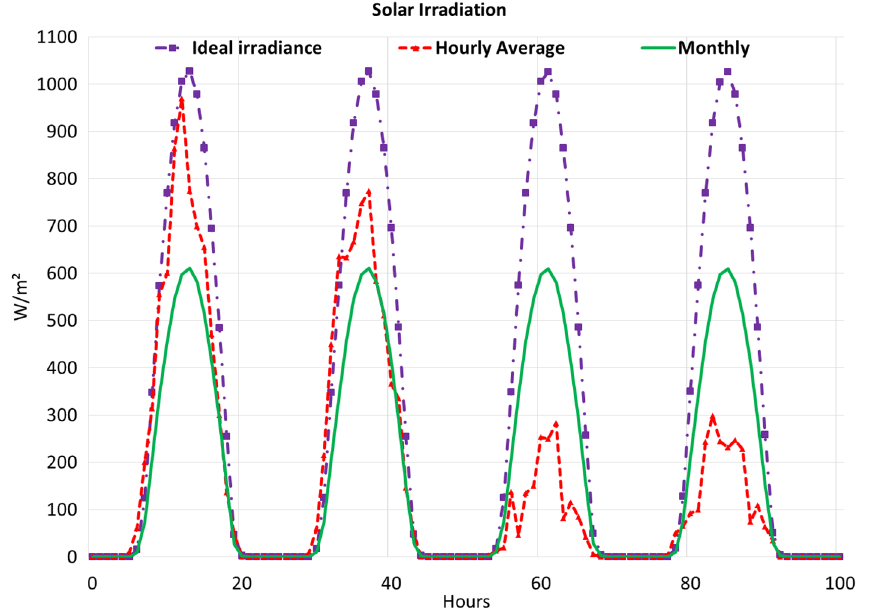
Figure 1. Example of the comparison between ideal, monthly and hourly average solar irradiance values (Paris: azimuth 0°; tilt